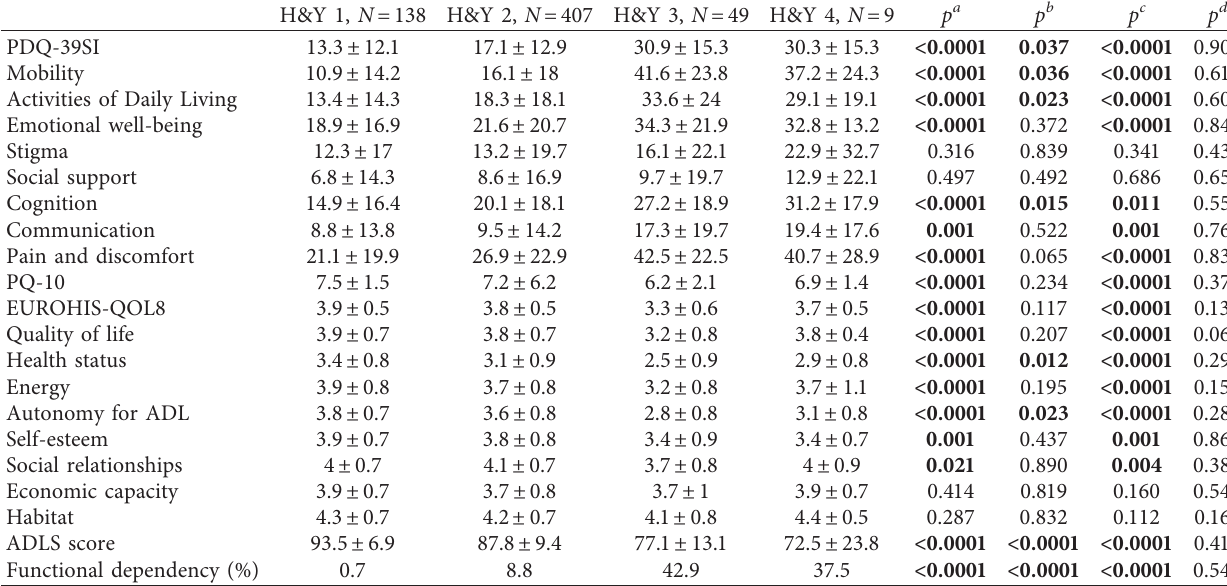
Figure 1: Total number (a) and percentage (b) of PD patients presenting with different stages of the HY.NMSB scale (from 1A to 4D) ( n � 603). Table 1: Quality of life (PDQ-39SI and EUROHIS-QOL8) and disability (ADLS score) in PD patients with regard to Hoehn and Yahr stage ( s �